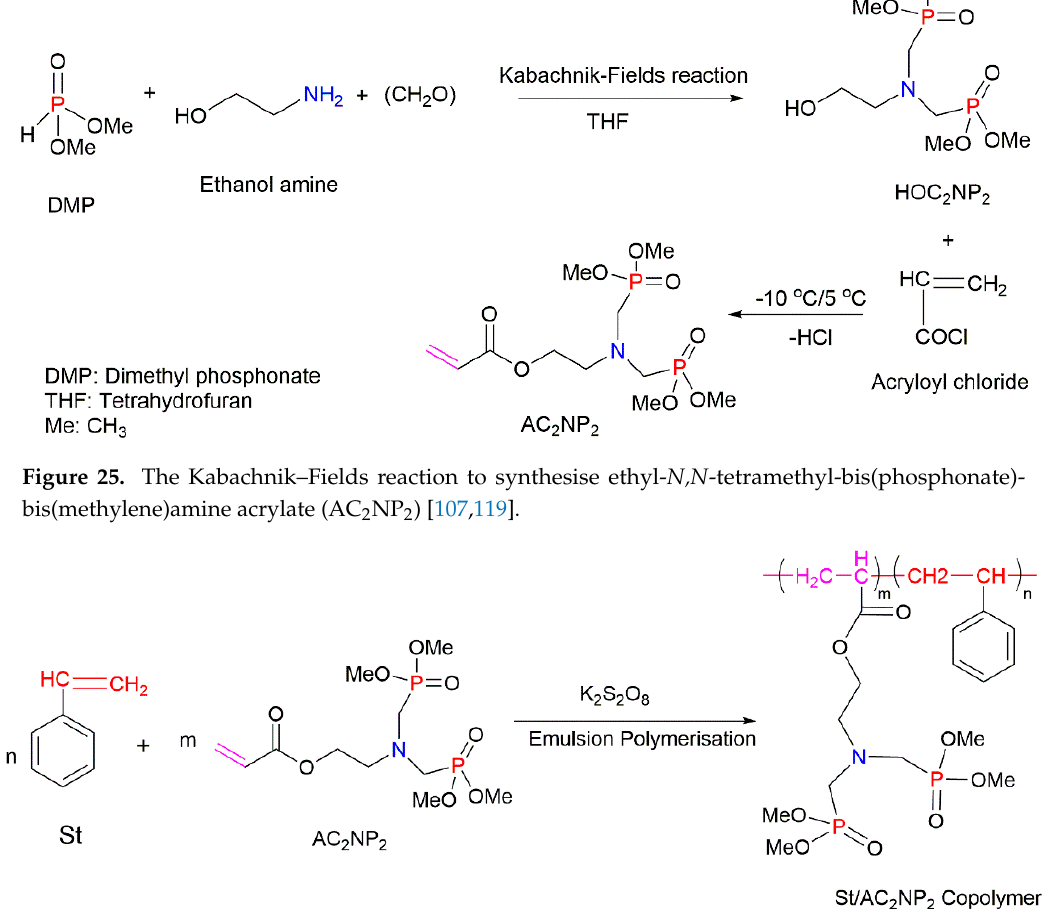
Figure 26. Emulsion polymerisation of St with AC 2 NP 2 [107].